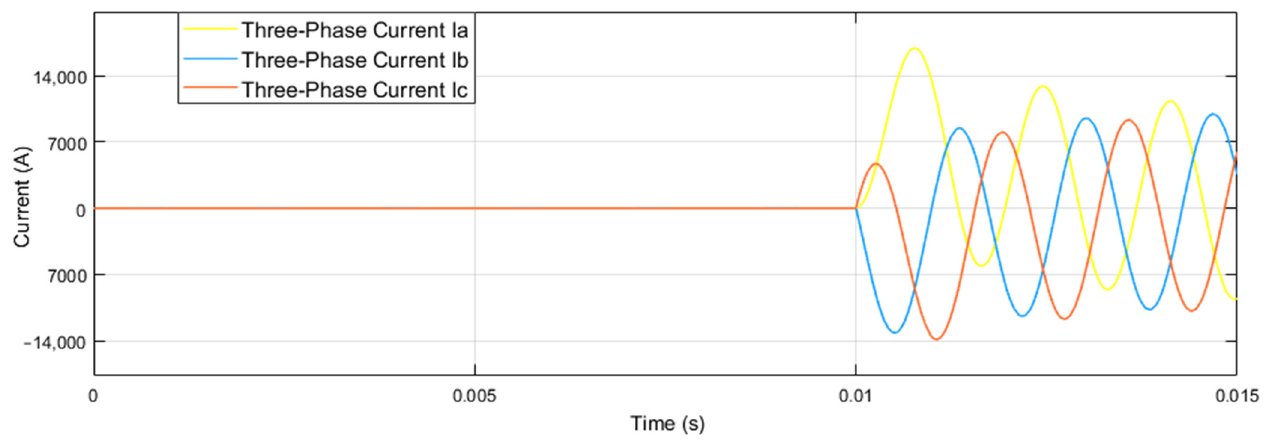
Figure 10. Three-phase current waveforms that ensure that the fault has been detected after 0.01